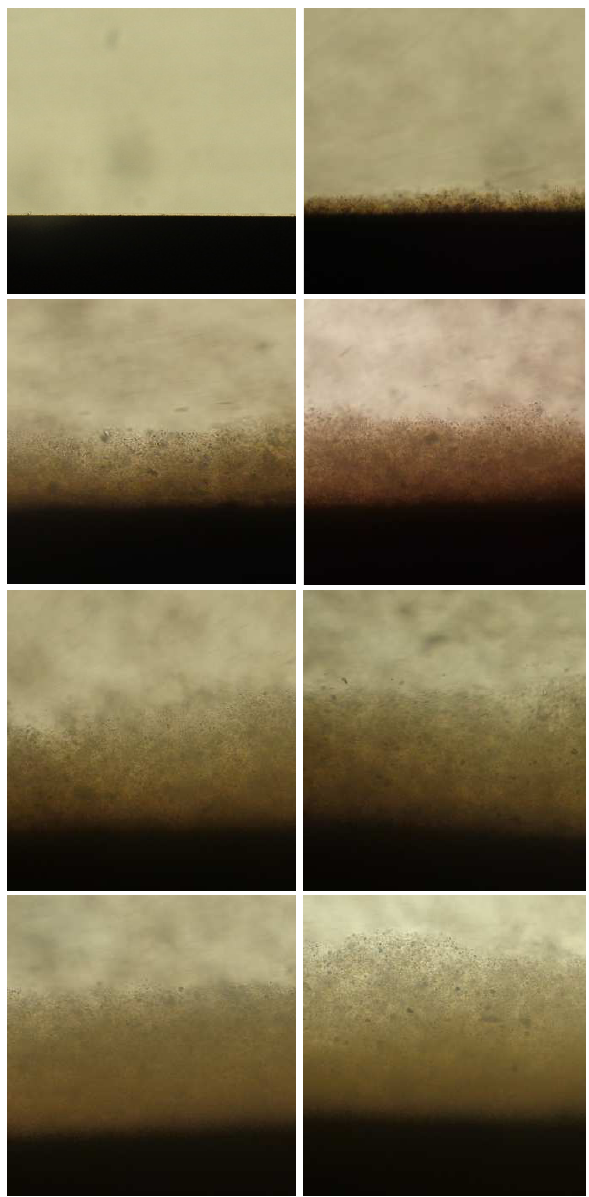
Fig. 8. Growth of fouling layer near the sealed end of the 15 cm hollow fiber membrane (images were taken at 20 minutes interval, the first image was taken at t = 0, while the last image was captured at t = 160